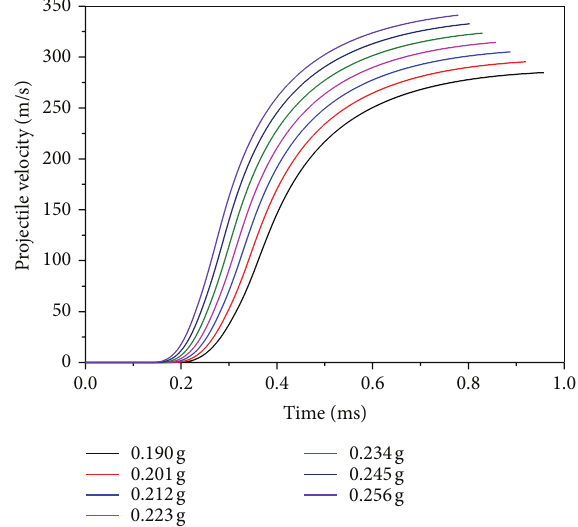
Figure 12: Shot velocity-time history for 𝑚 𝑝 ∈ [0.190g–0.256